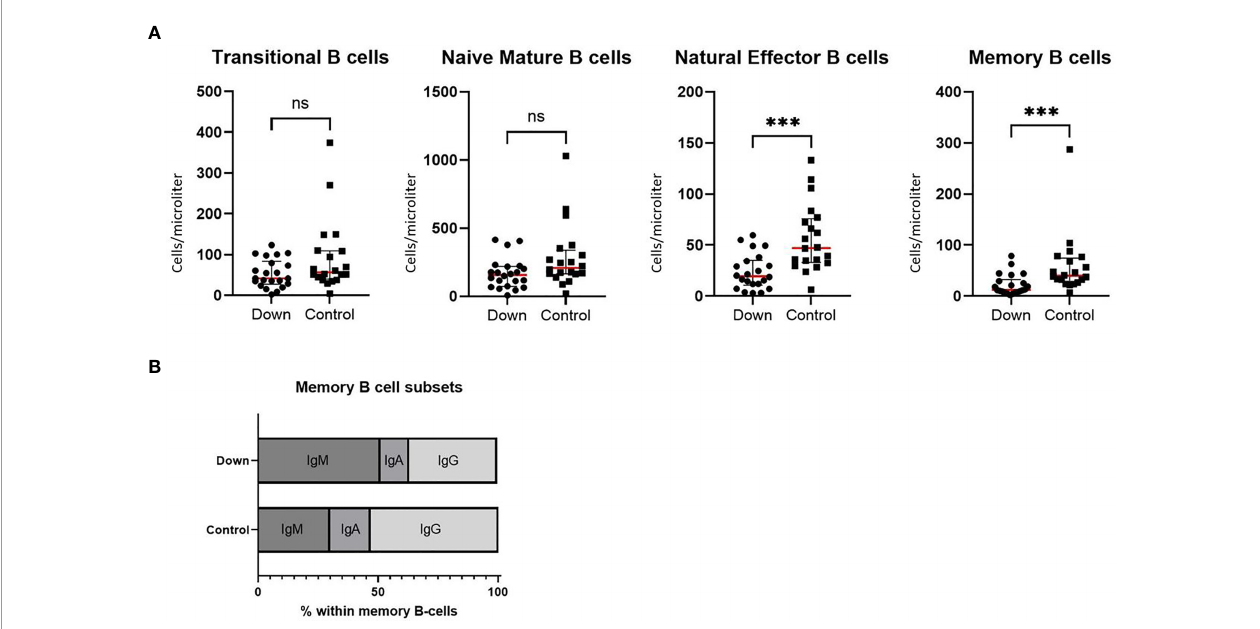
FIGURE 2 | Immunophenotyping of B cells in 22 children with Down syndrome and 20 healthy age-matched controls. (A) Absolute values of transitional B cells (CD38high/CD24high) and naive mature B cells (CD38dim/CD24dim/IgD+/CD27-) did not differ between children with Down syndrome and healthy controls, whereas natural effector B cells (CD38dim/IgD+/CD27+) and memory B cells (CD28dim/IgD-/CD27+) were signi fi cantly decreased in children with Down syndrome (resp. p =0.0002 and p =0.0004). Median and interquartile ranges are indicated (red lines represent the median). (B) In the subsets of memory B cells, children with Down syndrome have increased IgM memory B cells ( p <0.0001) and decreased IgA ( p =0.0003) and IgG ( p <0.0001) memory B cells. *** p < 0.001; ns p >